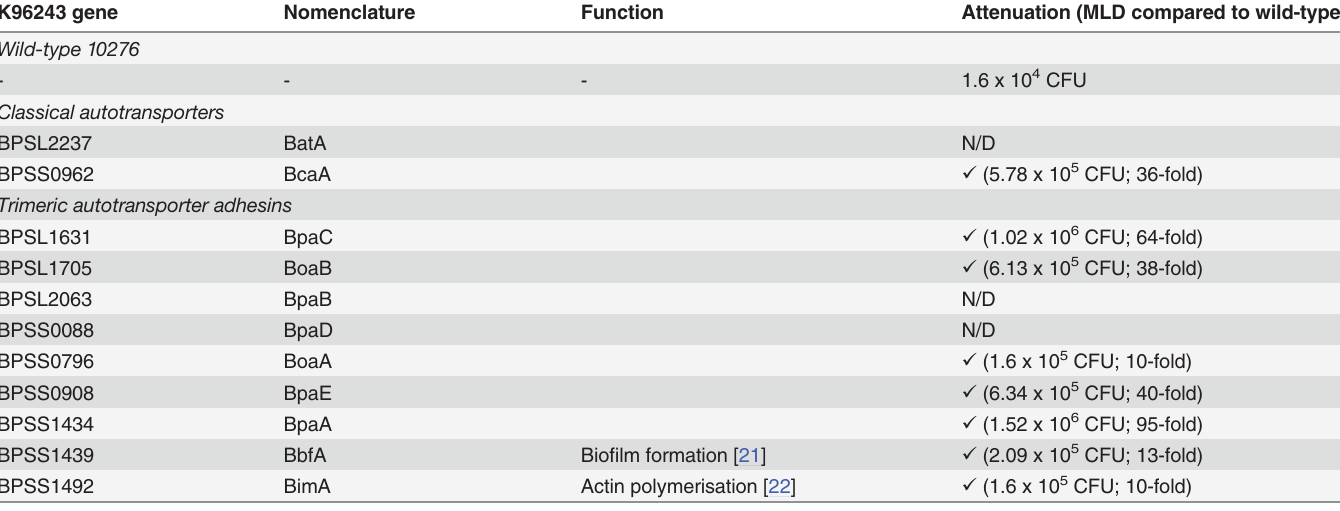
Table 3. Virulence of B . pseudomallei autotransporter mutants in a murine model of melioidosis. K96243